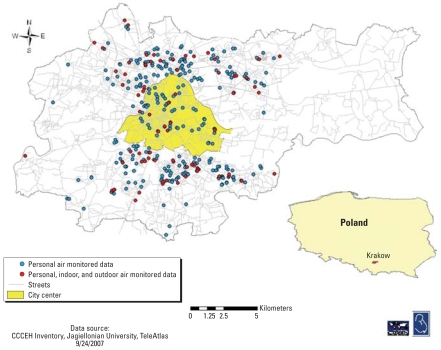
Home location of the pregnant women who completed personal and personal/indoor/outdoor monitoring. From Columbia Center for Children’s Environmental Health Inventory, Jagiellonian University, TeleAtlas, 24 September 2007.